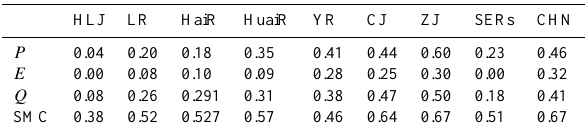
Table 6. Coefficient of determination R 2 , based on Pearson cor- relation, between precipitation ( P ), evapotranspiration ( E ), runoff ( Q ), soil moisture change (SMC) from GLDAS ensemble mean, and TWSC from the scaled GRACE data in